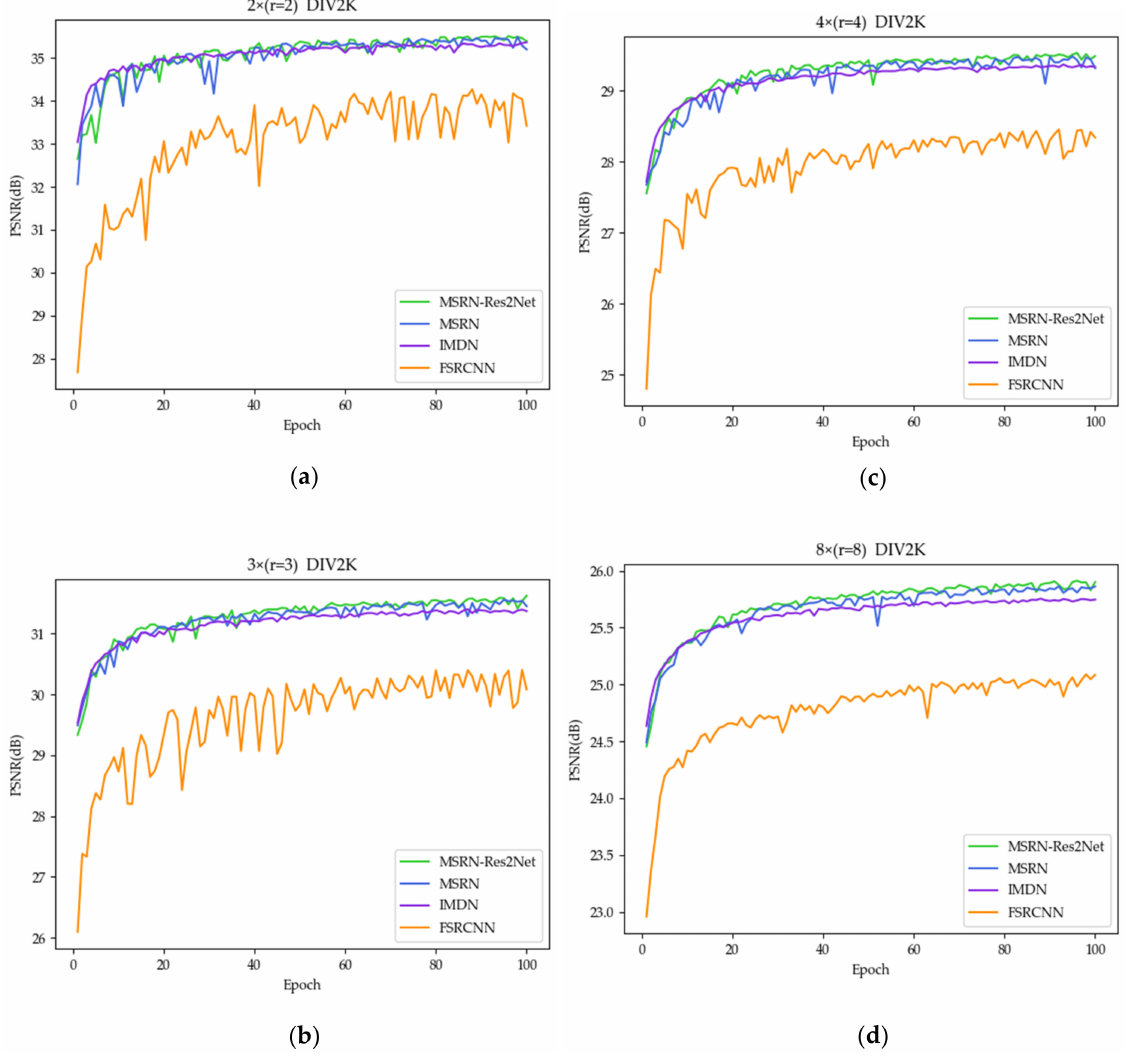
Figure 8. Comparison of the PSNRs of the MSRN (blue line), MSRN-Res2Net (green line), IMDN (purple line), and FSRCNN (orange line) with training on the DIV2K dataset and up-sampling factors r values of ( a ) 2, ( b ) 3, ( c ) 4, and ( d ) 8. The PSNR training curves of the deep network MSRN (blue line), MSRN-Res2Net (green line), and IMDN (purple line) are much higher than that of the shallow network FSRCNN (orange line). The MSRN-Res2Net has the highest PSNR curve and highest rising speed. As r increases, the distinction between MSRN-Res2Net and the other three curves becomes more obvious. To explain the necessity of adding Res2Net more effectively, Table 2 compares the four models according to the evaluation standard